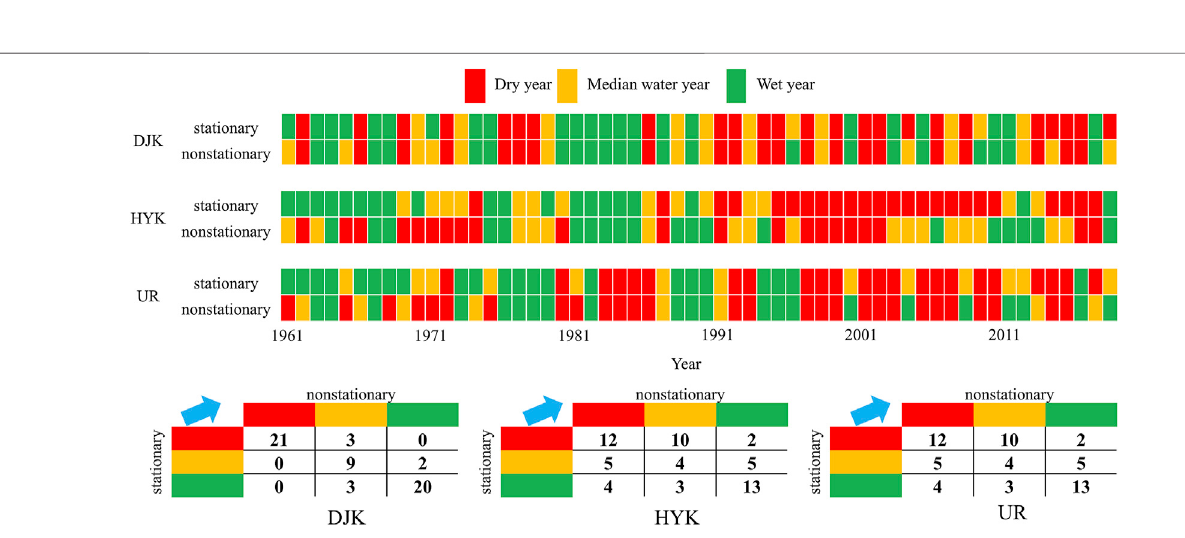
Frontiers in Environmental Science |